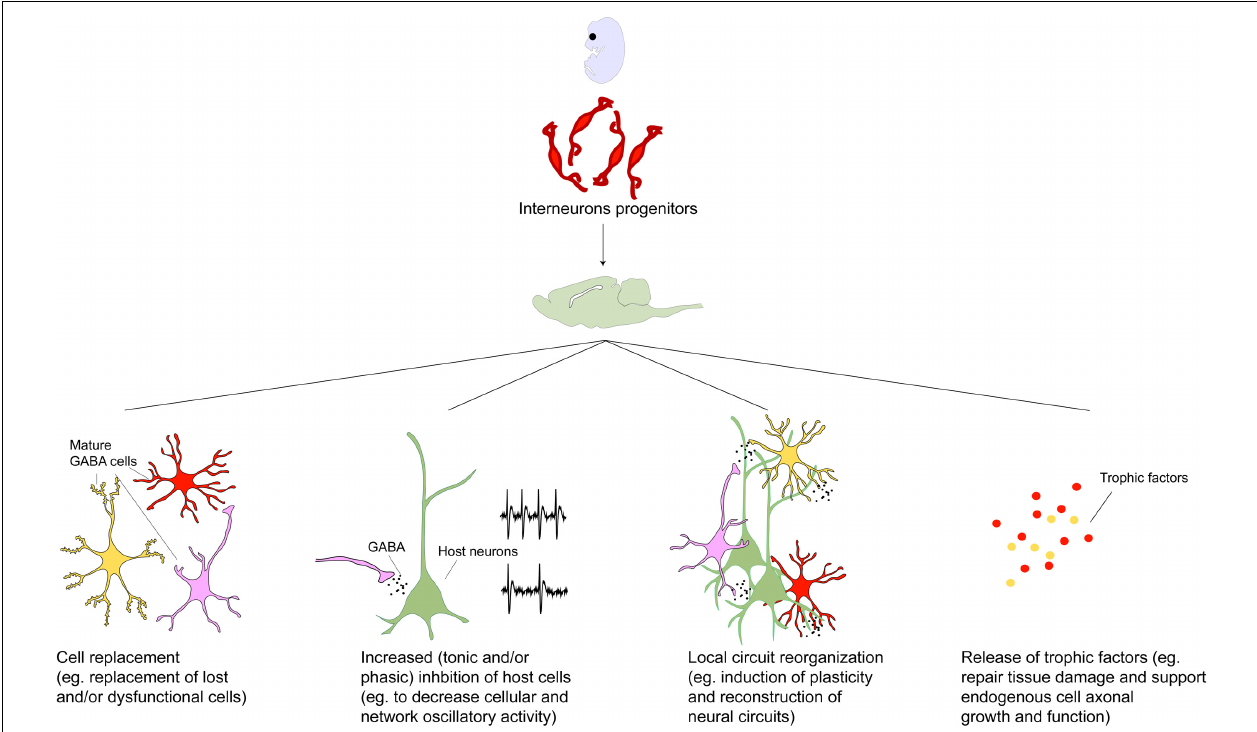
FIGURE 2 | Toward a mechanistic understanding of transplant induced therapeutics. Transplanted GABAergic interneurons make synaptic connections and enhance inhibitory tone within the host brain region (Alvarez-Dolado et al., 2006; Baraban et al., 2009). The importance of these new synaptic connections has been demonstrated in the mature visual cortex where interneuron progenitor implantation but not pharmacological GABA augmentation induces cortical plasticity and reopening of critical period (Fagiolini and Hensch, 2000; Hensch, 2005; Southwell et al., 2010; Davis et al., 2015). This has been attributed to the numerous, individually weak inhibitory connections made by the transplanted neurons which may trigger local circuit reorganization (Southwell et al., 2010). However, given that the behavioral effects of GABAergic interneuron transplants are not phenocopied by local pharmacological enhancement of GABA transmission, and sparseness of transplanted neurons relative to the host population, it has been hypothesized that therapeutic effects of transplants may be mediated by mechanisms beyond that of GABA replacement (Gilani et al., 2014; Southwell et al., 2014). Intriguingly, transplanted neural stem cells have been demonstrated to rescue dysfunctional host dopamine neurons in MPTP-treated aged animals (Ourednik et al., 2002). Other proposed effects independent of synaptic connections with host neurons include secretion of neuroprotective factors (Capone et al., 2007; Redmond et al., 2007; Liang et al., 2014; Goldberg et al., 2015). In addition transplanted neural cells have been proposed to create homeostatic environments by releasing factors that repair and counter inflammation and scarring (Park et al., 2002; Lee et al., 2007). More recently, interrogation of host circuit physiology following engraftment of undifferentiated and non-integrating cells revealed a dose-dependent dampening of cortical excitability and depletion of host cell populations underscoring the importance of engraftment density in designing cell based therapeutic protocols (Weerakkody et al., 2013). Considering the wide-ranging repertoire of transplant-induced effects, discovery of molecular mechanisms underlying these may uncover